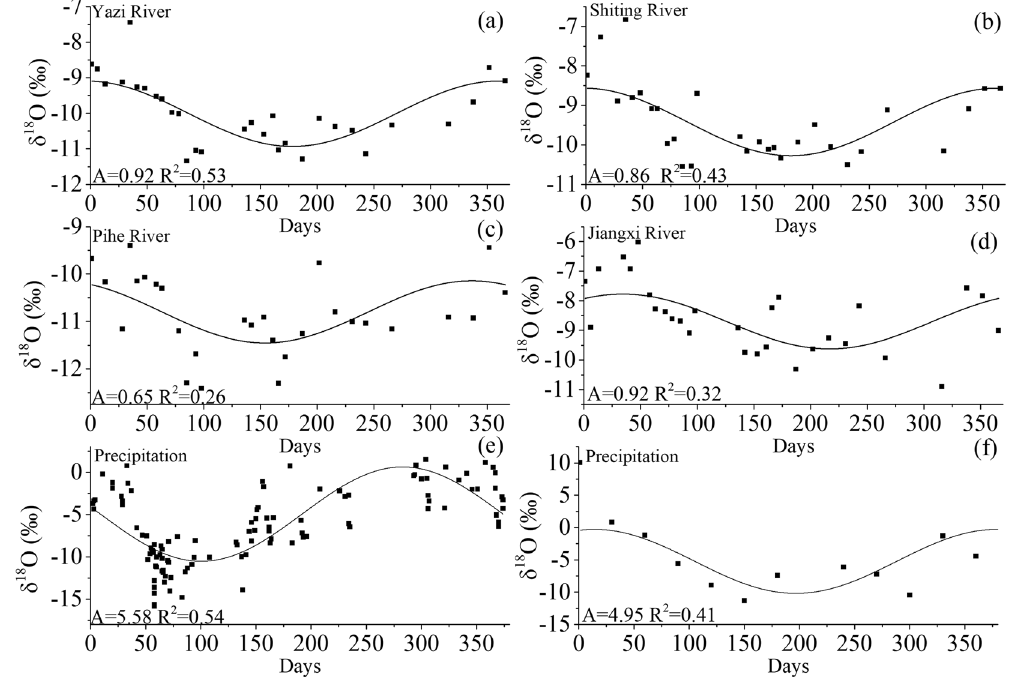
Figure 4. Fitted annual regression models to δ 18 O for precipitation ( e ) and river water ( a – d ) during 2018–2019. ( f ) is the fitted annual regression models to δ 18 O for precipitation at Chengdu City during 1996–1997.